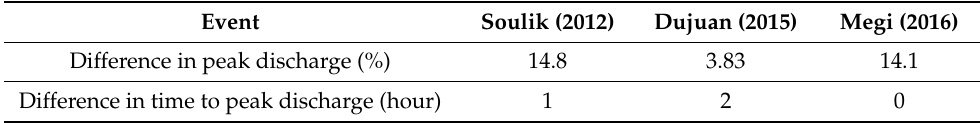
Table 2. The validated performance of HEC-HMS for three typhoons. Event Soulik (2012) Dujuan (2015) Megi (2016) Difference in peak discharge (%) Difference in time to peak discharge (hour) 1 2